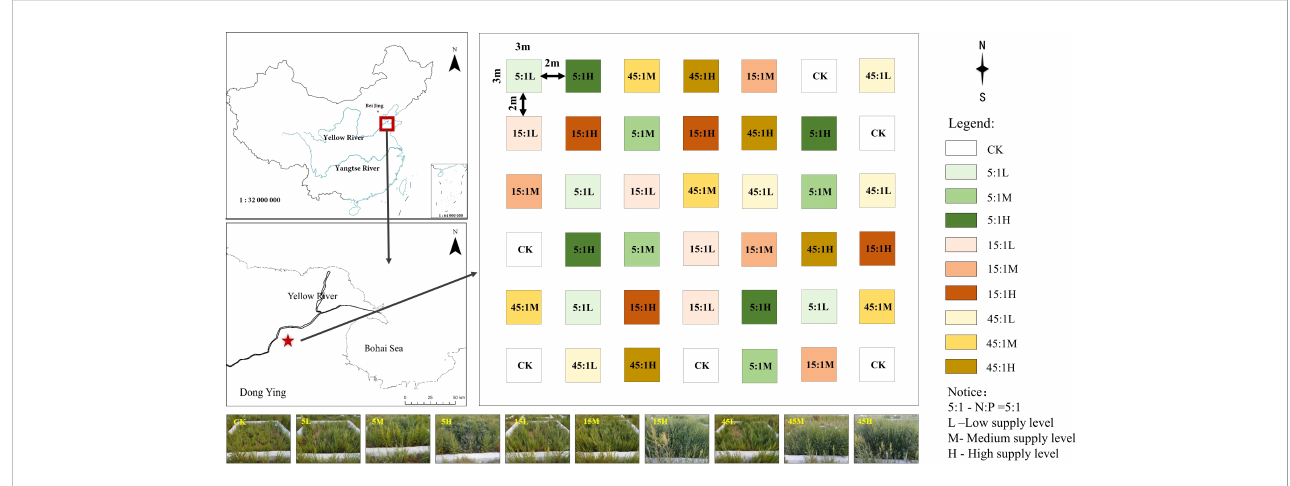
FIGURE 1 Location and layout of the experimental